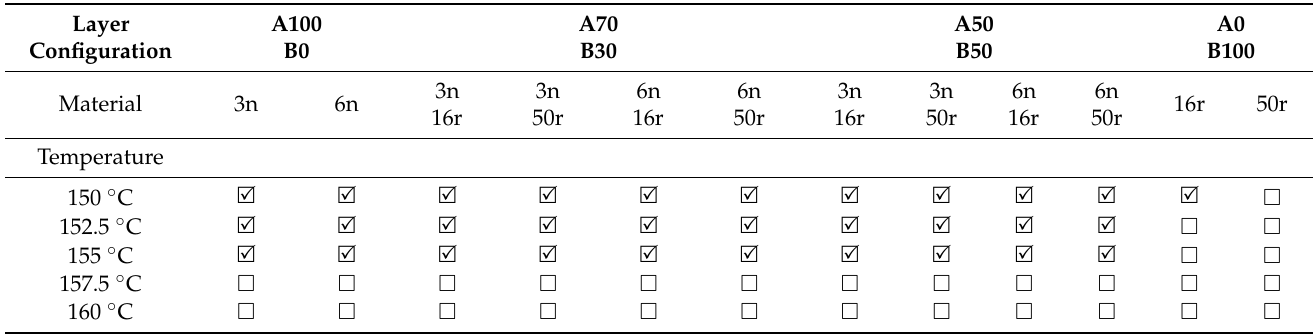
Table 3. Possible temperatures for biaxial stretching tests. Layer